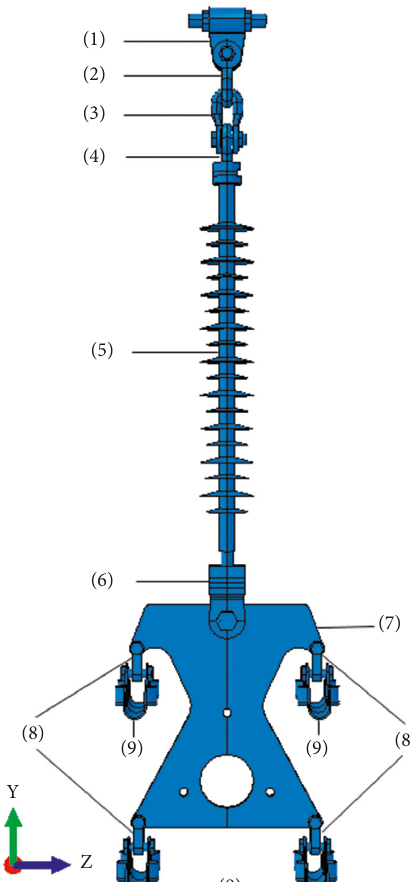
Figure 18: Integral model of suspension